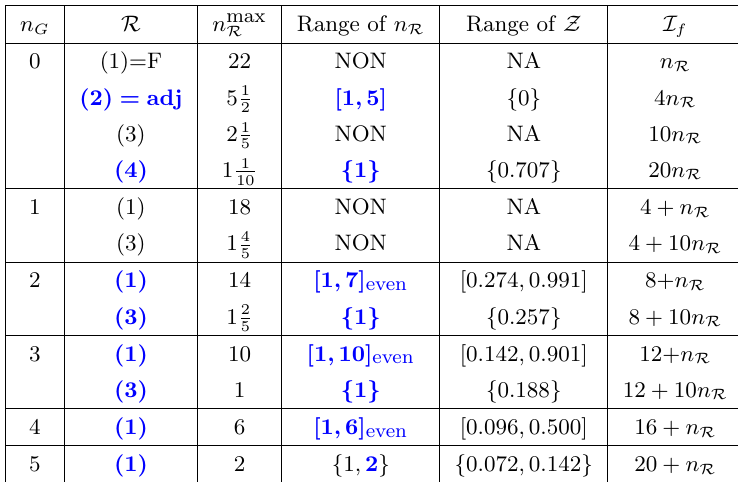
Table 1 . su (2): classi(cid:12)cation of all asymptotically free theories. The (cid:12)rst column, n G , is the number of the adjoint fermions. In the second column we list the asymptotically free theories with fermions in representation R . In the third column we give the maximum number of R fermions, n max , in R the presence of n G fermions such that the theory remains asymptotically free. The fourth column gives the range of fermions that lead to a global minimum (or minima) of the e(cid:11)ective potential inside the a(cid:14)ne Weyl chamber. This range is represented either as an interval [ n 1 ; n 2 ] (keeping R R in mind that we really mean the integer values of the fermion number), or as a list of numbers f n 1 ; n 2 ; : : : g . The abbreviation NON indicates the absence of a global minimum inside the a(cid:14)ne R R Weyl chamber. The (cid:12)fth column gives the deviation of the global minimum of the potential from the center symmetric point as de(cid:12)ned in (6.3). In particular, we give the range of Z as an interval [ Z 1 ; Z 2 ], where Z 1 corresponds to n 1 and Z 2 corresponds to n 2 . Notice that we do not compute R R Z for theories with no global minima inside the a(cid:14)ne Weyl chamber. The (cid:12)nal column gives the Atiyah-Singer index in the background of a Belavin-Polyakov-Schwarz-Tyupkin (BPST)